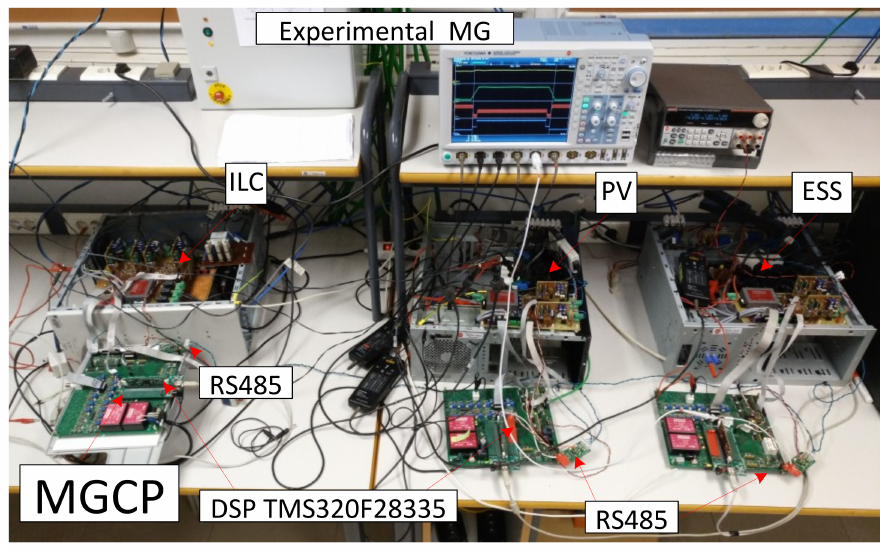
Figure 9. Experimental setup